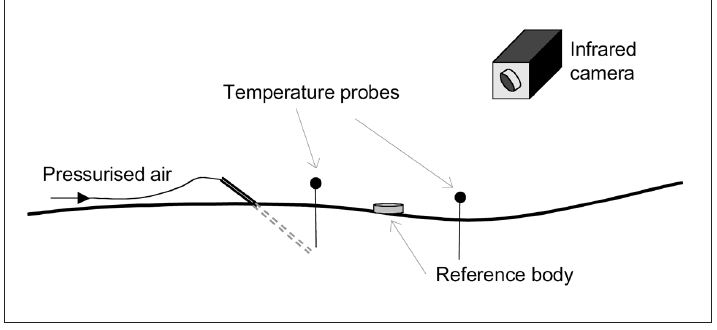
Fig. 5. Schematic view of experiment setup: lance; two temperature sensors, one at the air outlet, the other off- side, tips are 10 cm below the surface; the infrared camera is approximately 5 m away from the test field.